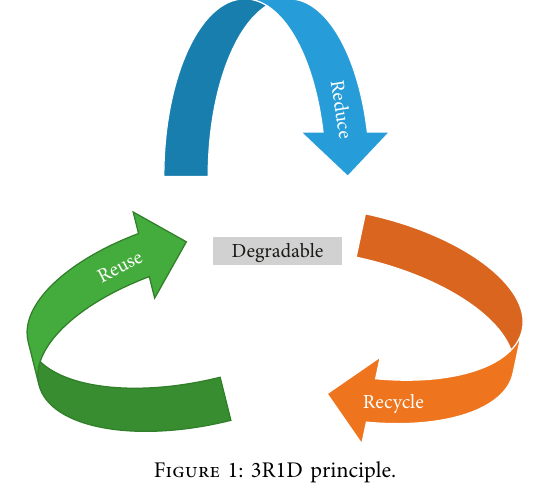
Figure 1: 3R1D principle.